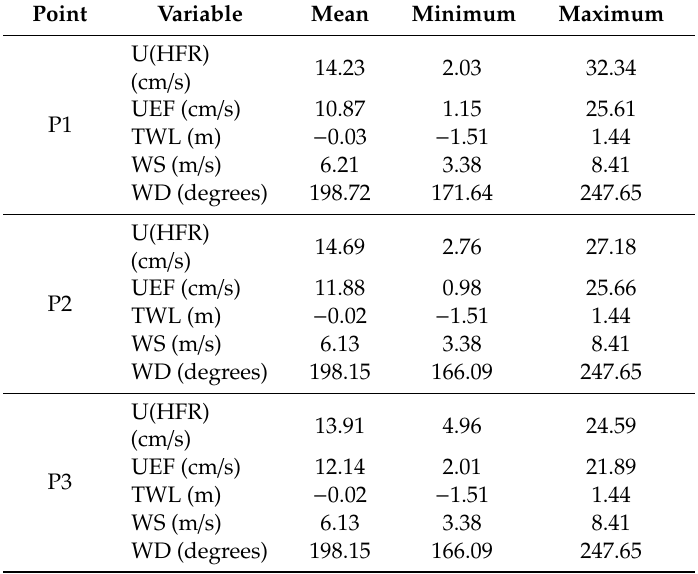
Table 2. Mean and range of testing dataset (20% of total